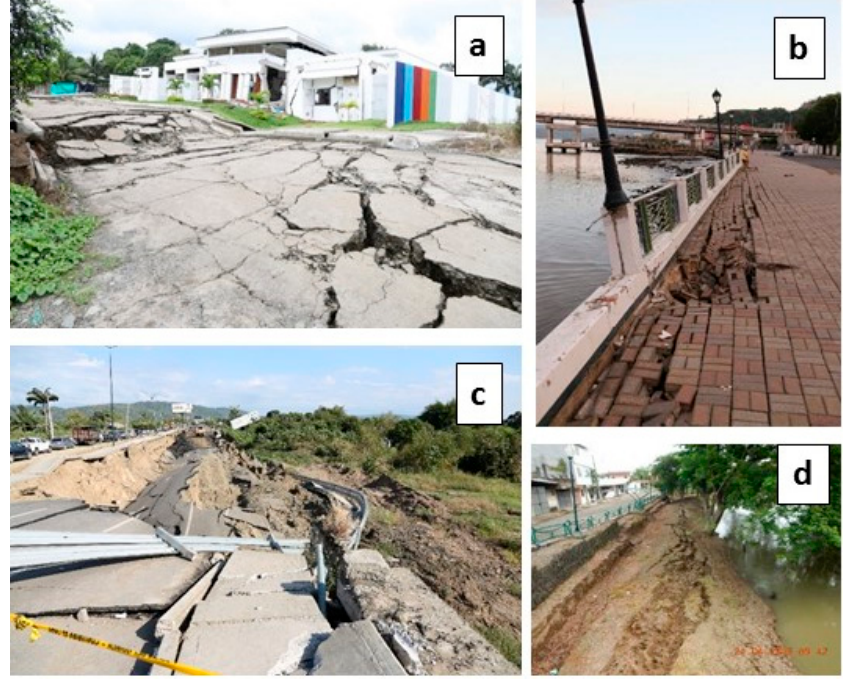
Figure 3. Example of mapped lateral spread landslides: a ) deformation in alluvial plain at Jama site, the road is completely displaced for tens of meters, severe damage affected the local